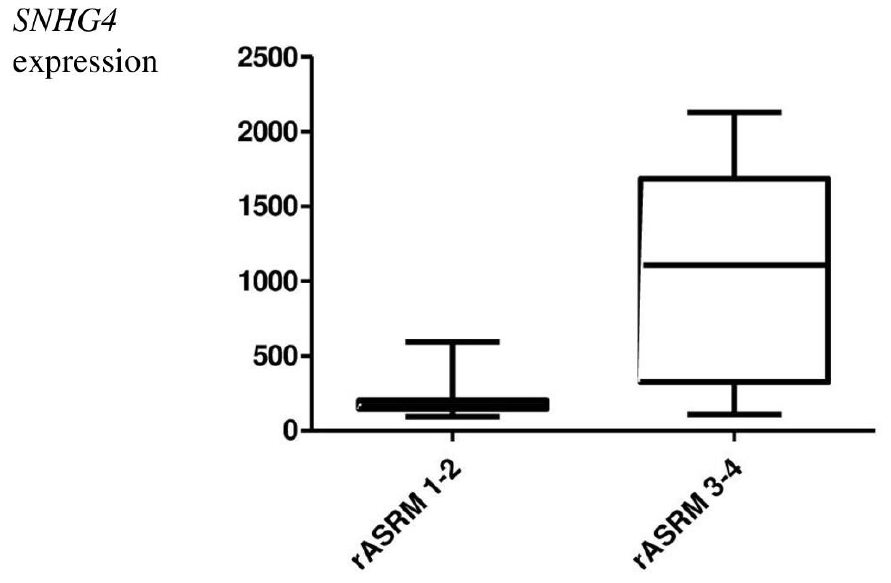
Figure 5. Relative expression of the SNHG4 gene in endometriosis patients with respect to the rASRM classification (Mann–Whitney test; p = 0.031).